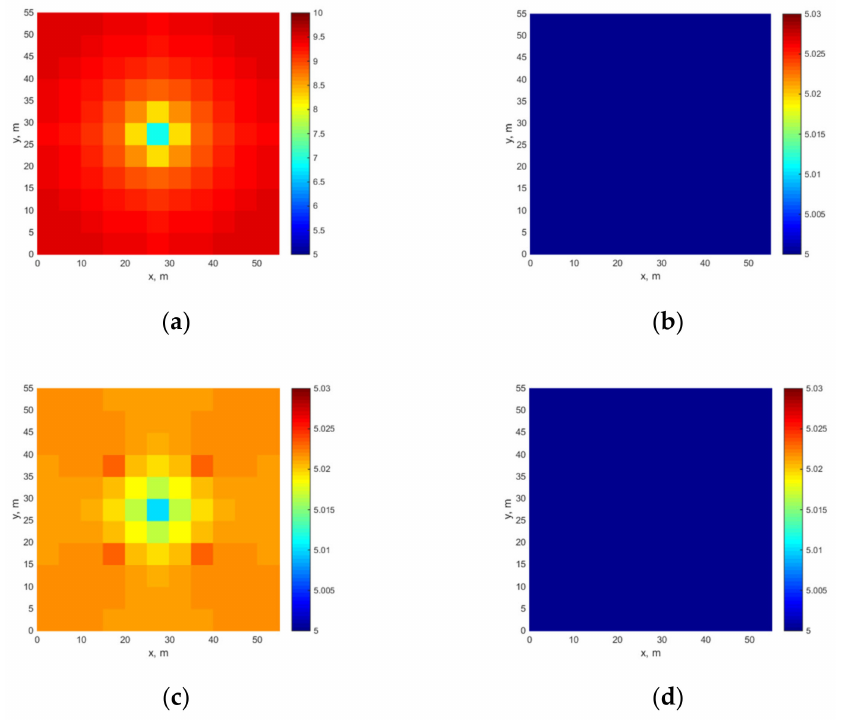
Figure 3. Reservoir pressure profiles calculated by this method.